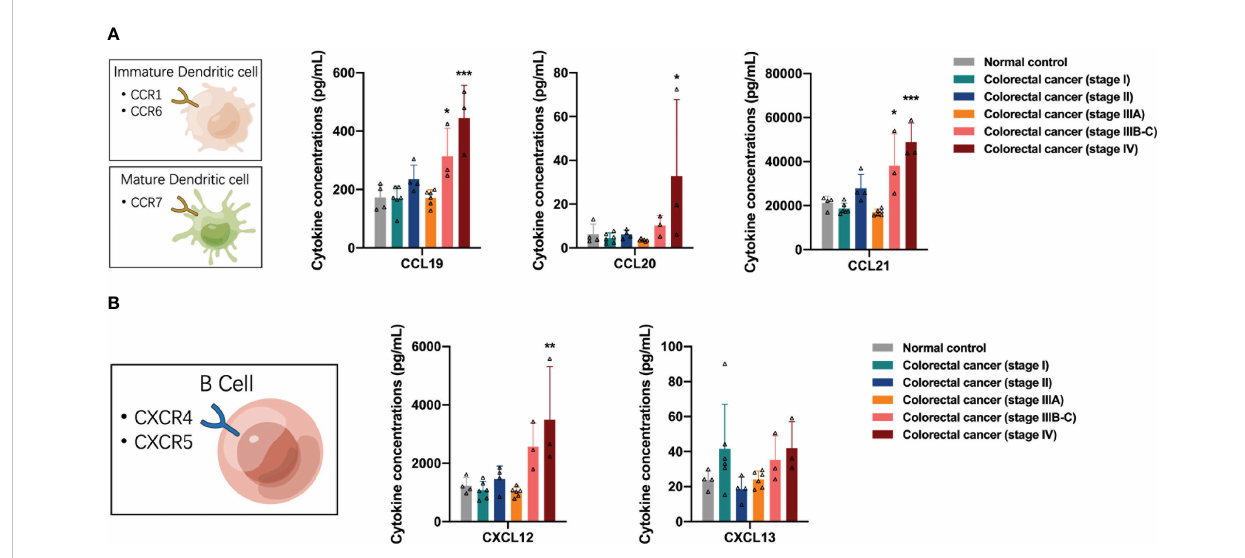
FIGURE 4 Distribution of antigen-presenting cell-associated cytokines in the peripheral blood of the participants. (A) The concentrations of dendritic cells chemotaxis-associated proteins CCL19, CCL20 and CCL21 were elevated in the peripheral blood of patients with stage IIIB-C and IV colorectal cancer. (B) The concentrations of CXCL12 were increased in the peripheral blood of patients with advanced colorectal cancer. Data are presented as mean±SD, one-way ANOVA, * p <0.05, ** p <0.01, *** p